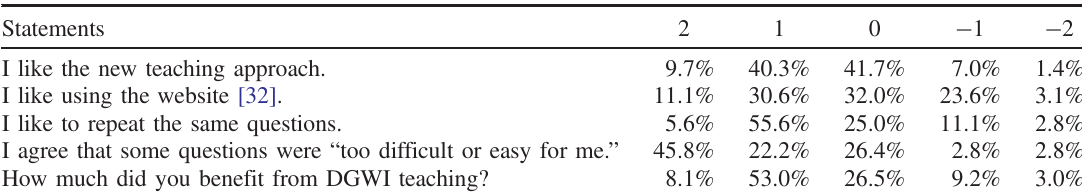
TABLE VII. Student survey results. (The numbers represent the percentage of students who chose a particular